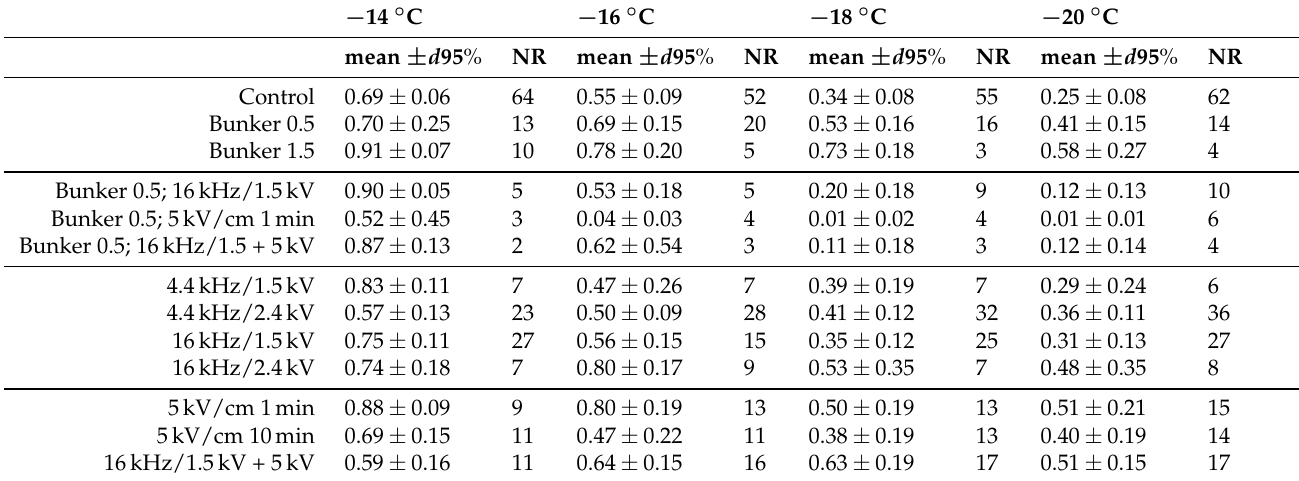
Table 3. Relative frost resistance of two-stage hardened seedlings after various seed treatments. mean ± d 95 % indicates the mean value with 95% confidence interval, NR indicates the number of repetitions. Designations of variants coincide with designations in Tables 1 and 2.